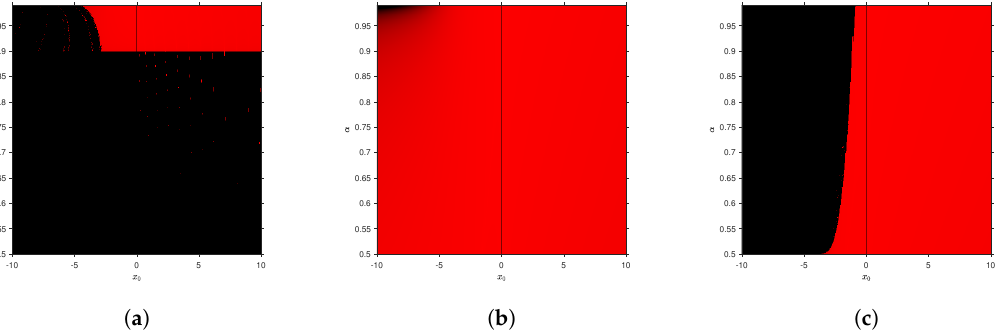
Figure 3. Convergence planes of fractional Newton-type methods on f 2 ( x ) with − 10 ≤ x 0 ≤ 10. ( a ) CFN 1 , 13.83% convergence; ( b ) CFN 2 , 99.62% convergence; ( c ) CFT, 57.78% convergence.